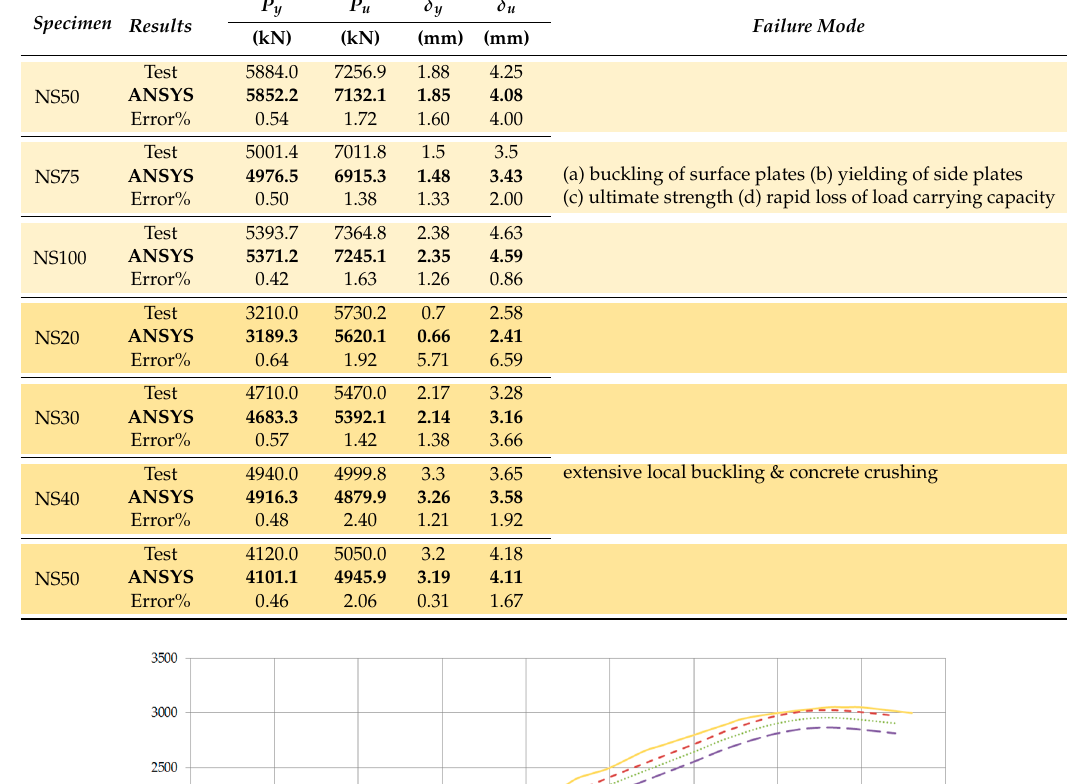
Table 2. Experimental versus numerical modelling results.